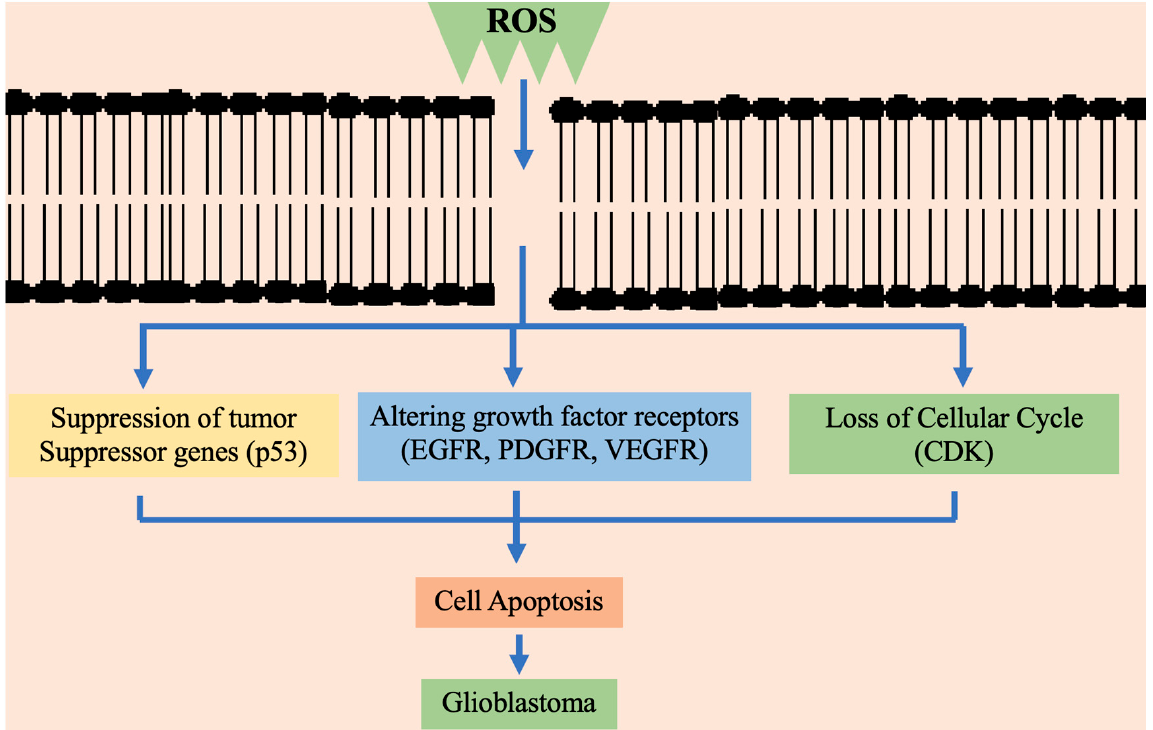
Figure 2. Schematic representation of ROS affecting different mechanistic pathways in cell proliferation and apoptosis in glioblastoma multiforme. EGFR—epidermal growth factor receptor; PDGFR—platelet-derived growth factor A receptor; VEGFR—vascular endothelial growth factor; CDK—cyclin-dependent kinase.